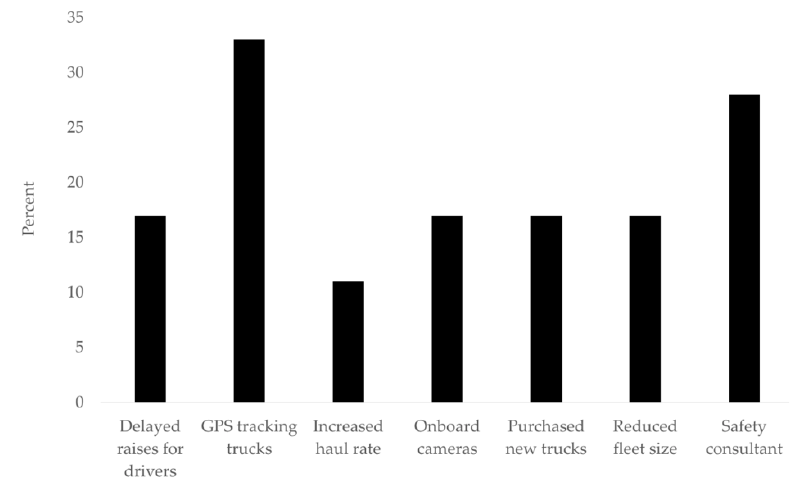
Figure 3. Response of interviewees to increases in insurance premiums.